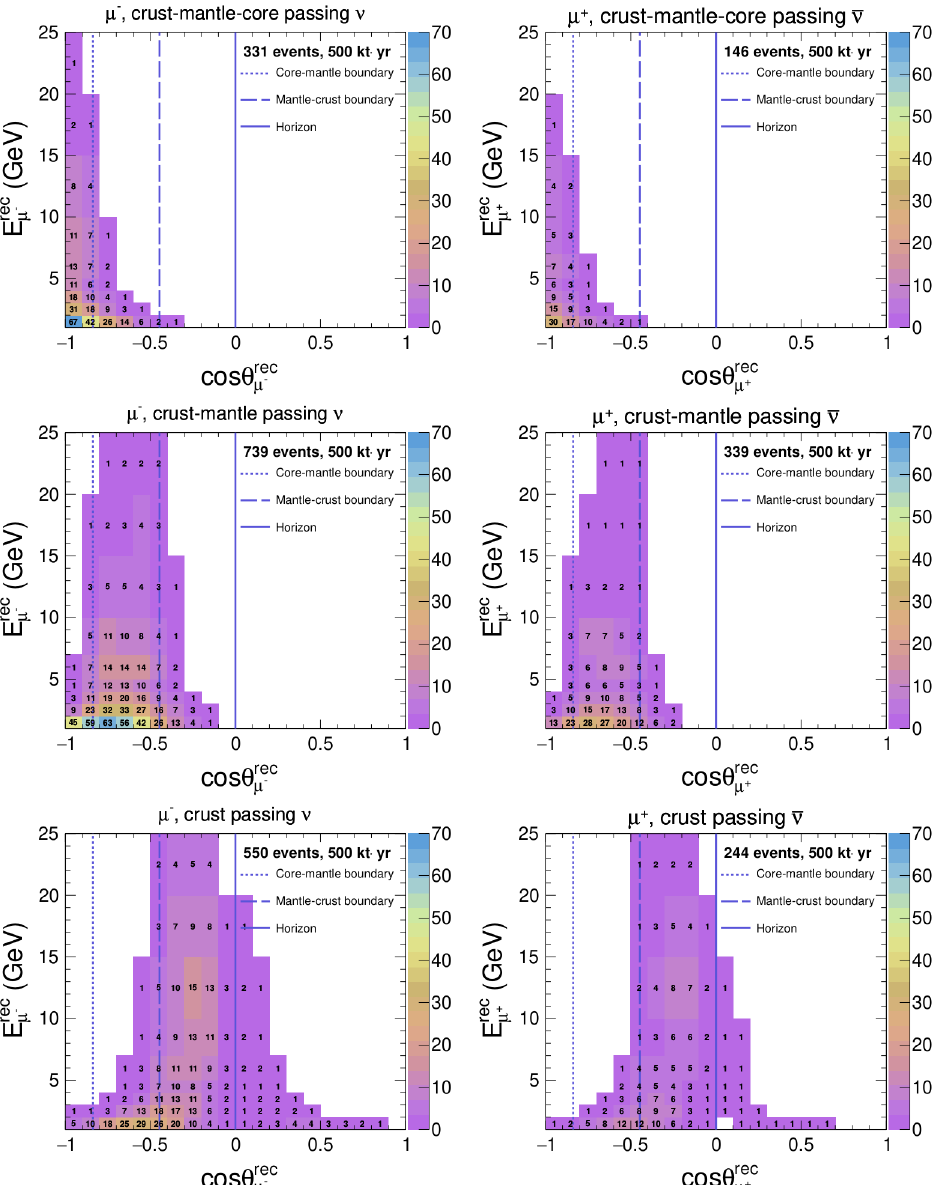
Figure 5 . Reconstructed muon event distribution at ICAL for 500 kt · yr exposure for neutrinos traversed through various regions in the Earth. These reconstructed muon events for 10 years are scaled from 1000-year MC data. We consider three-flavor neutrino oscillations in the presence of matter with the PREM profile. We take the three-flavor oscillation parameters from table 2. We assume NO and sin 2 θ = 0 . 5 . The top, middle, and bottom panels show the distribution of 23 reconstructed muon events for the parent neutrinos passing through the crust-mantle-core, crust- mantle, and crust, respectively. The dotted, dashed, and solid vertical blue lines correspond to the core-mantle boundary, mantle-crust boundary, and horizontal direction, respectively. The Left (right) panel shows reconstructed µ − ( µ + )